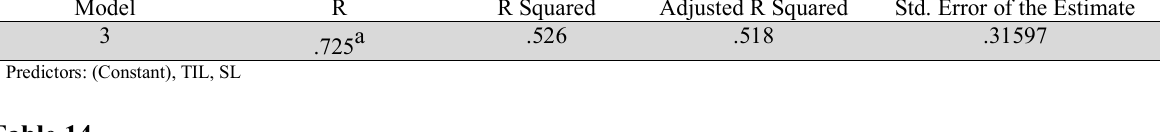
Model 3 regression – ANOVA a Model Sum of Squares Df Mean Squares F Sig. Regression 12.531